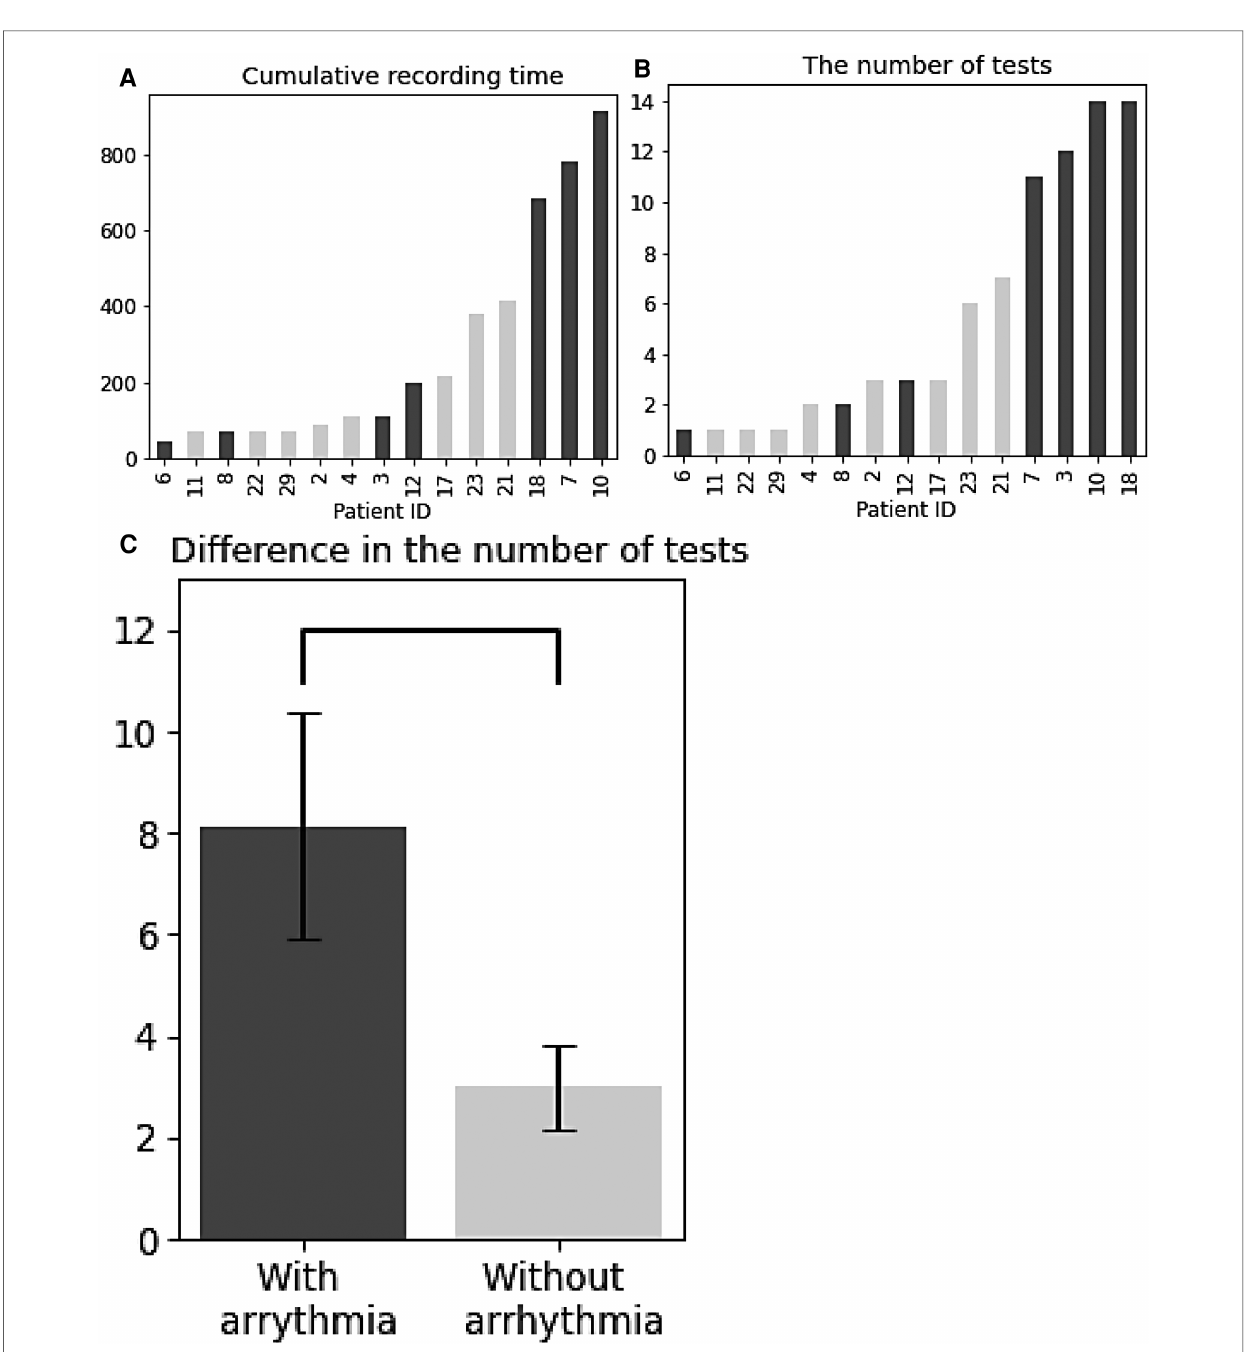
FIGURE 3 Overall data summary. ( A ) Cumulative recording time for patients. ( B ) The number of tests for patients. ( C ) Difference in the number of tests between patients with and without arrythmia. ( A – C ) Patients with arrhythmia are shown in dark